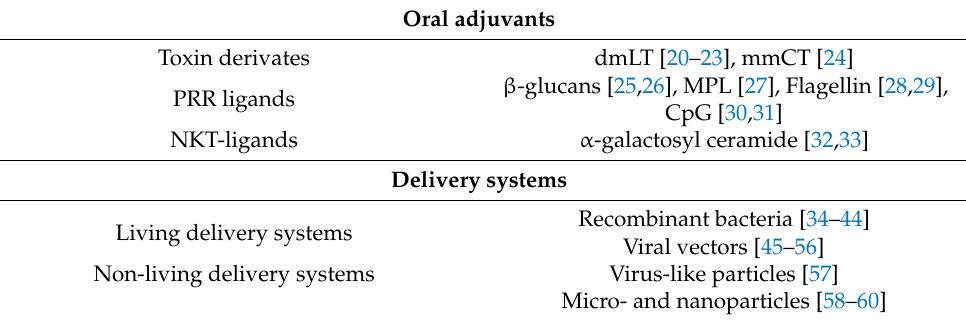
Table 1. Overview of different oral vaccination strategies studied for oral